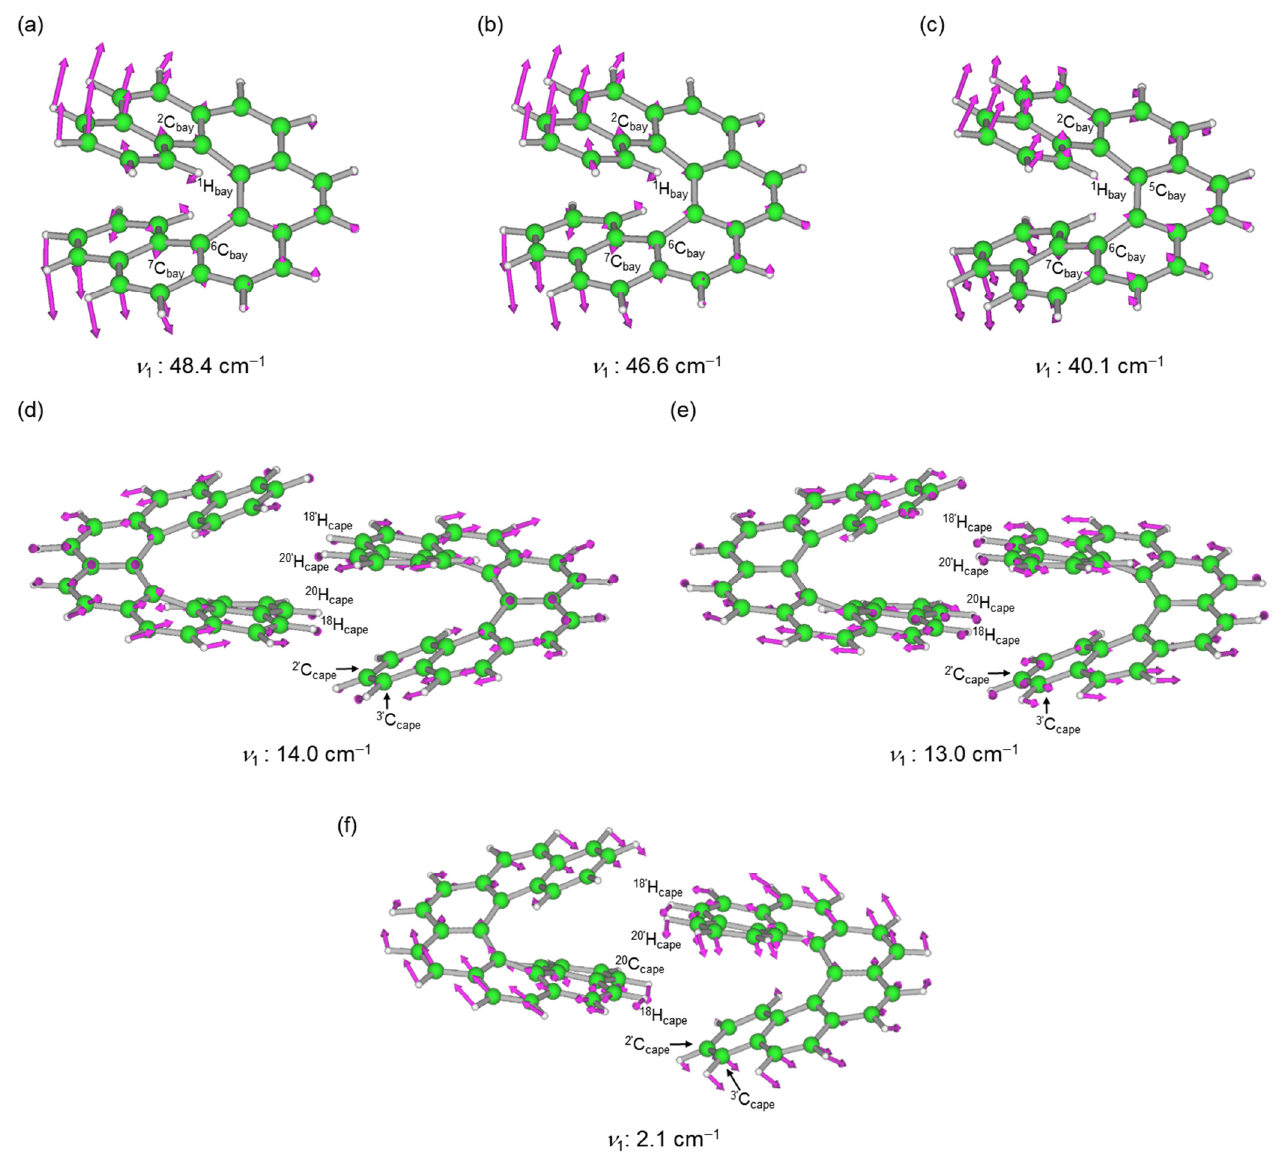
Figure 7. The internal vibrational motions of ν 1 for 7 ( C 2 ) and 7 : 7 ( C i ). ( a ) For 7 ( C 2 ) calculated with M06-2X/6-311+G(3d,p); ( b ) for 7 ( C 2 ) calculated with M06-2X/6-311+G(2d,p); ( c ) for 7 ( C 2 ) calculated with LC-ωPBE/6-311+G(2d,p); ( d ) for 7 : 7 ( C i ) calculated with M06-2X/6-311+G(3d,p); ( e ) for 7 : 7 ( C i ) calculated with M06-2X/6-311+G(2d,p); ( f ) for 7 : 7 ( C i ) calculated with LC-ωPBE/6-311+G(2d,p). The 20 C cape - - 18’ H cape distance was optimized to be 3.236 Å, which is longer than The calculated r ( 1 H bay ··· 6 C bay ) and r ( 2 C bay ··· 7 C bay ) distances were 2.590 Å and 2.975 Å, r ( 20 H cape ··· 18’ H cape ) (2.947 Å) by 0.288 Å with LC-ωPBE/6-311+(2d,p). However, a BP was respectively, for 7 , when calculated with M06-2X/6-311+(3d,p), while the values were detected for 20 C cape - - 18’ H cape but not for 20 H cape - - 18’ H cape . The difference in the atomic size 2.590 Å and 3.003 Å, respectively, when calculated with M06-2X/6-311+(2d,p). The dif- between C and H, such as the van der Waals radii, may be responsible for the predicted ferences are less than 0.001 Å for r ( 1 H bay ··· 6 C bay ) and 0.028 Å for r ( 2 C bay ··· 7 C bay ). The results show that the structure of 7 optimized with M06-2X/6-311+(2d,p) appears to be nearly identical to that optimized with M06-2X/6-311+(3d,p). On the other hand, the r ( 1 H bay ··· 6 C bay ) and r ( 2 C bay ··· 7 C bay ) of 7 were 2.561 Å and 3.227 Å, respectively, if calcu- lated with LC- ω PBE/6-311+(2d,p). The difference was − 0.029 Å for the former but 0.224 Å for the latter relative to the corresponding values calculated with M06-2X/6-311+(2d,p). The structure of 7 optimized with LC- ω PBE/6-311+(2d,p) appears to be (very) different from that optimized with M06-2X/6-311+(2d,p), especially around r ( 2 C bay ··· 7 C bay ). In the case of 1 H bay ··· 5 C bay , the distance was optimized to be 2.468 Å with LC- ω